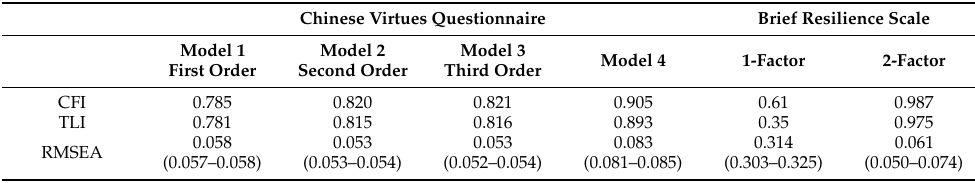
Table 3. Model Fit Indices for the Chinese Virtues Questionnaire and Brief Resilience